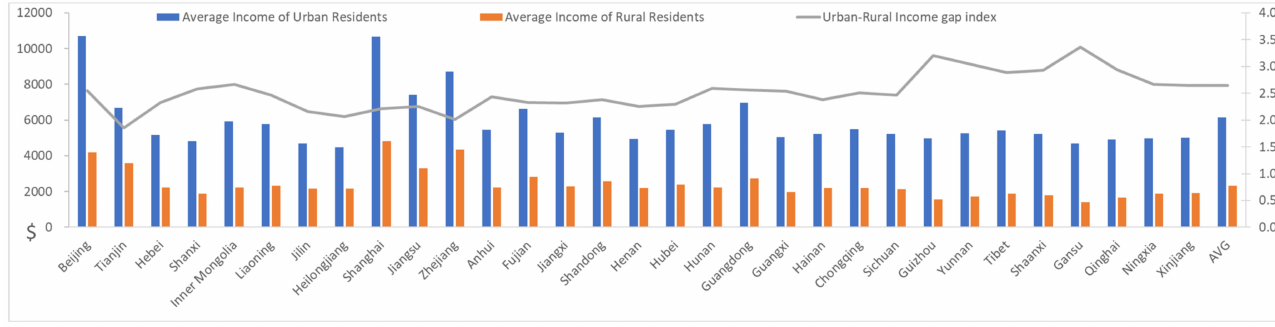
Figure 3. Comparative analysis of urban–rural income gap in China’s provinces.